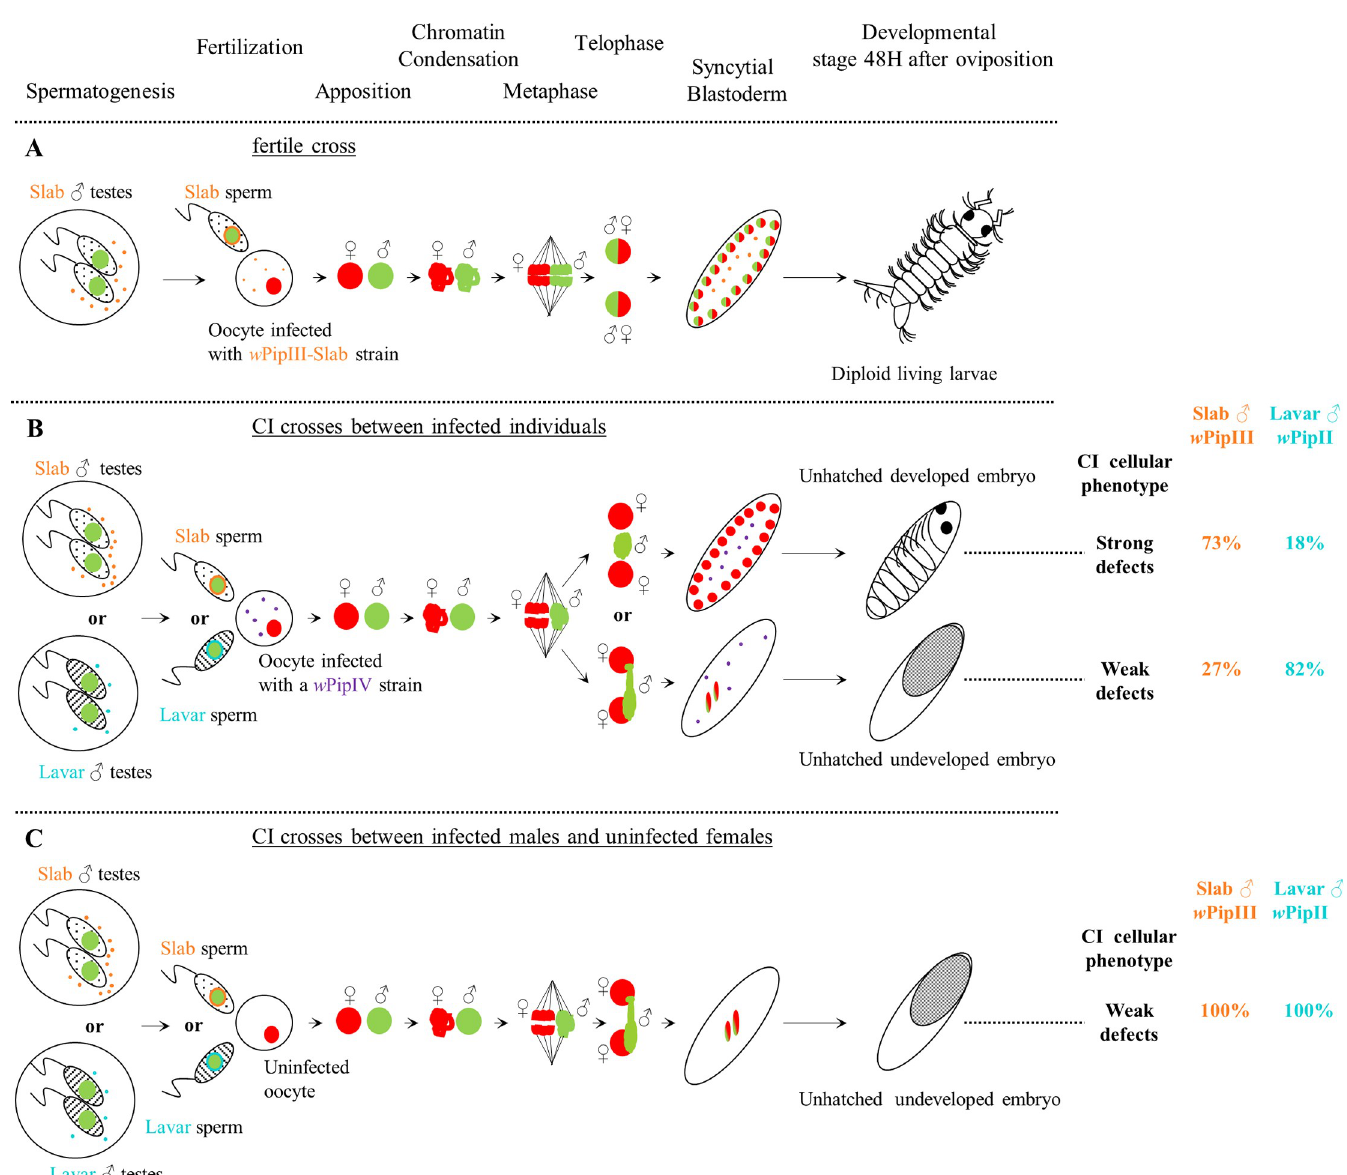
Fig 6. Cellular bases of different developmental fates in C . pipiens : From spermatogenesis to late development stages. Paternal and maternal DNA are represented in green and red respectively and Wolbachia cells are represented by the small dots (blue for w PipII; orange for w PipIII and purple for w PipIV). The two M AL lines Slab and Lavar have been chosen to illustrate the variability in CI defects intensity ( i . e . frequency of strong and weak cellular CI). During spermatogenesis, the Wolbachia in male testes produce a toxin ( mod factor). After fertilization, if females and males are infected with the same Wolbachia (Panel A), they can prevent the toxicity ( resc function) and allow normal embryogenesis and the production of living diploid larvae. However, if the Wolbachia in the females are incompatible with the Wolbachia in the males (Panel B) or absent (Panel C) then the toxicity would not be prevented and paternal chromatin condensation delay and segregation defects occur. Two outcomes of the first zygotic division are possible regarding the degree of paternal chromatin exclusion. If the paternal chromatin is partially excluded, chromatin bridges would be formed resulting in aneuploid nuclei which might go through few mitotic divisions but will arrest the embryogenesis at early stages producing embryos with no visible development. If the paternal chromatin is fully excluded from the first zygotic division, maternal chromatin can segregate and produce two haploid nuclei which will divide further to produce non-viable haploid embryos exhibiting advanced development stages with eyes and segmentation clearly visible. The proportion of unhatched haploid embryos is influenced by different w Pip with distinct mod profiles in the M AL lines involved in the crosses. However when the egg is not infected by Wolbachia (Panel C), all embryos exhibited an absence of further development after the first zygotic divisions whatever the mod induced by the w Pip hosted by the M AL